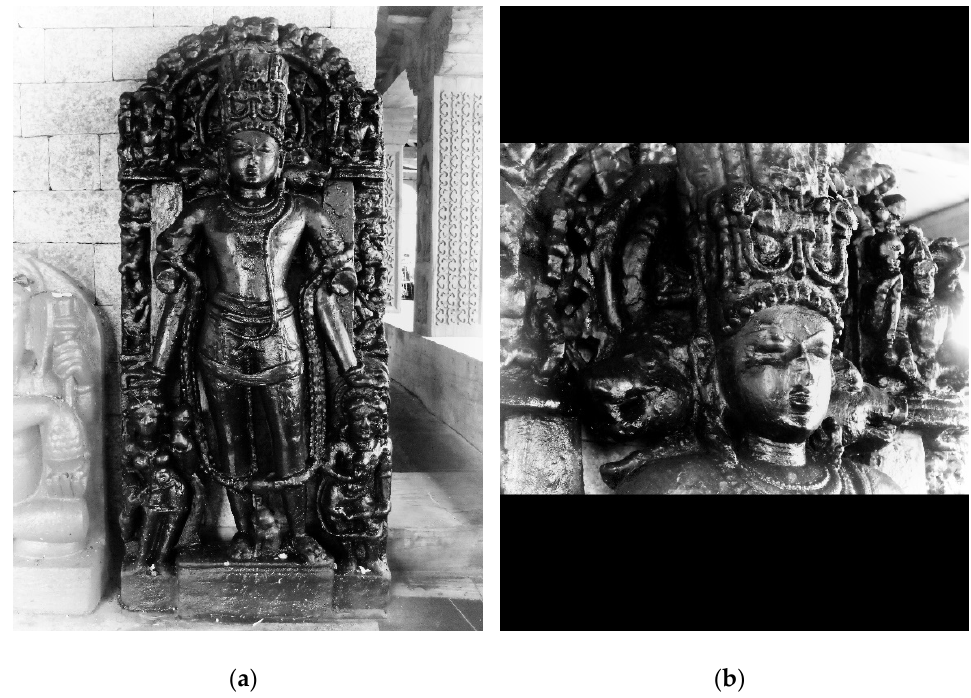
Figure 3. ( a ) Vis.n.u as Vaikun.t.ha, Mamel; ( b ) The Kashmiri-style polycephalic image suggests Figure 3. ( a ) Vi ṣṇ u as Vaiku ṇṭ ha, Mamel; ( b ) The Kashmiri-style polycephalic image suggests prov- provenance in circa 850 CE. Photographed by the author in enance in circa 850 CE. Photographed by the author in 2013.